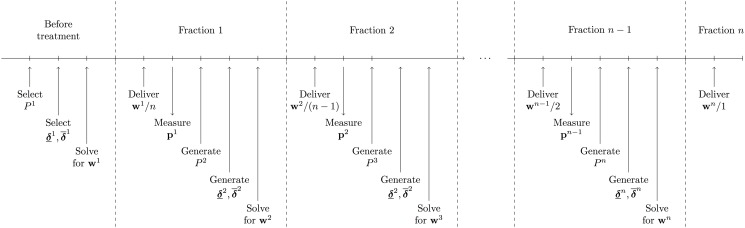
Schematic of dose-reactive method.